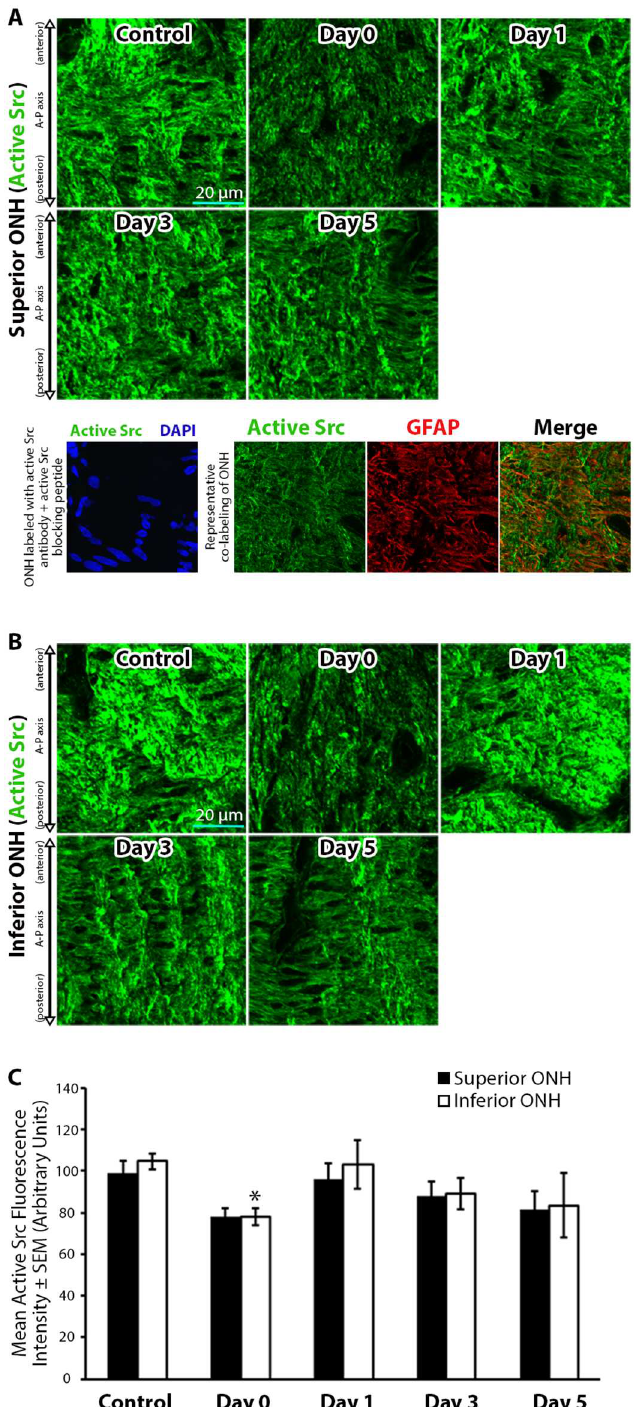
Fig 5. Active Src kinase levels within the optic nerve head are reduced immediately and transiently after intraocular pressureelevation. (A-B) Superiorand inferior optic nerve head(ONH) sections labeled with antibodiesagainst active Src kinase in control eyes and eyes exposedto 8 hours of intraocular pressure (IOP) elevation.The bottom panels in (A) includea validationof antibody specificity using an active Src specific blockingpeptide(bottom left panel), as well as an exampleof co-localization of active Src with astrocyte specific anti-glialfibrillary acidic protein (GFAP) antibodies(bottom right panels). Note